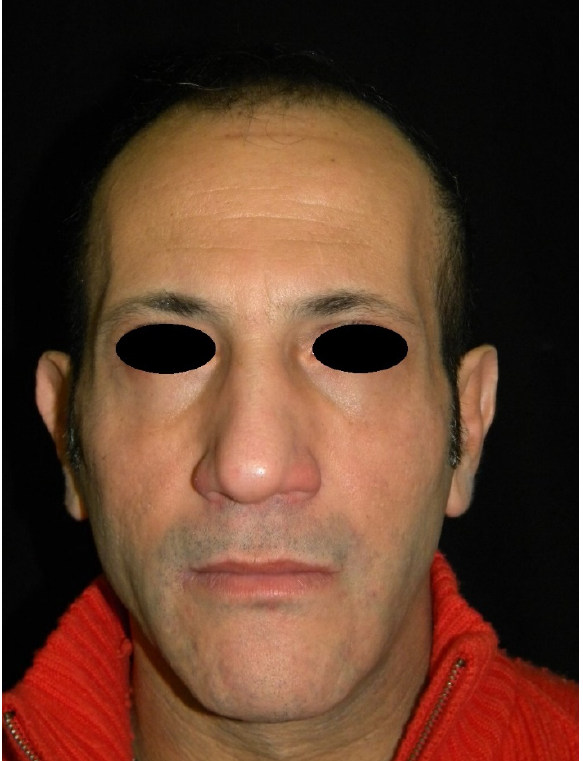
Figure 2. Frontal view of a patient presenting facial wasting (the same patient shown in Figure 1) treated with polyacrylamide hydrogel filler, at 6 months follow-up.